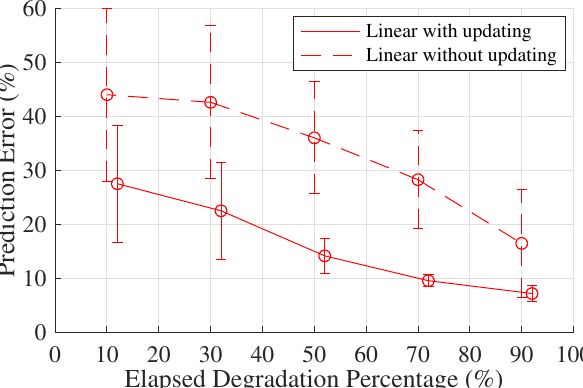
Figure 7. A comparison between the ‘linear with updating model’ and the ‘linear without updating model’ regarding residual life prediction